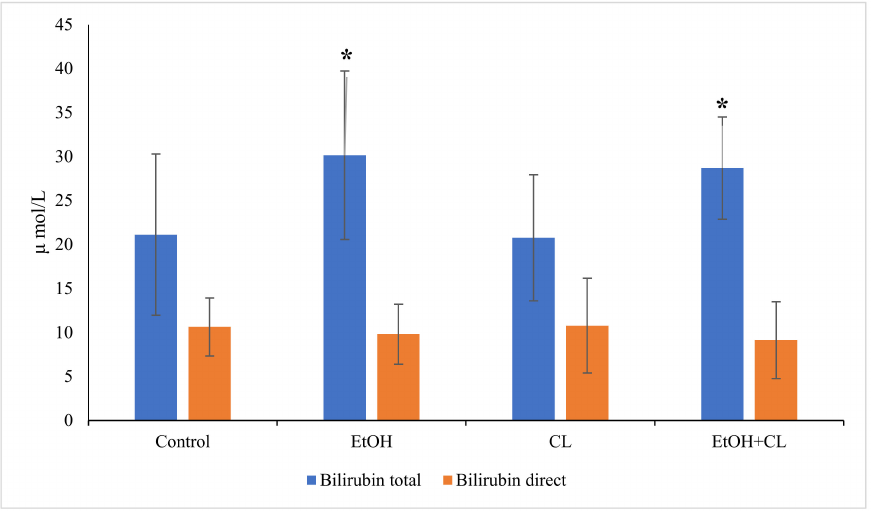
Figure 9. Content of direct and total bilirubin in the blood plasma of rats, * p <